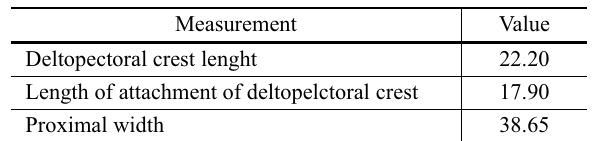
Measurements (in mm) of MB.R. 2828.